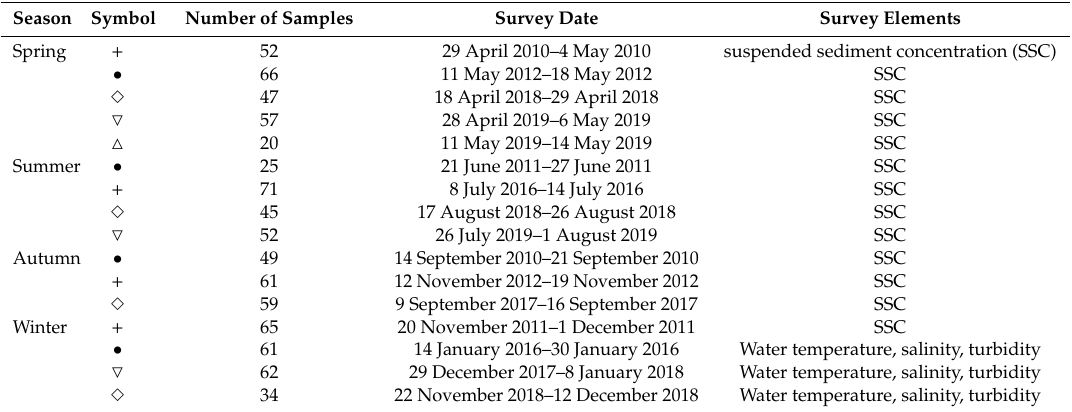
Table 1. Information about the cruises from 2010 to 2019.